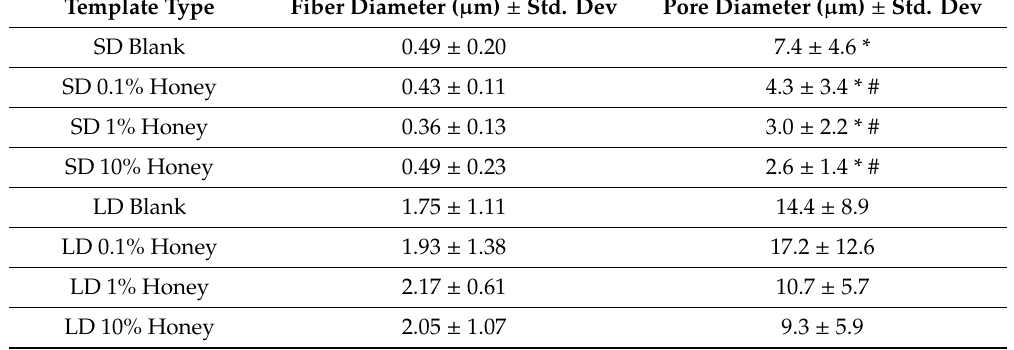
Table 3. Fiber diameters and pore diameters of each template type (mean ± standard deviation). * indicates a significant di ff erence between the pore diameters of the LD and SD templates at each honey condition. # indicates a significant di ff erence from the non-honey blank with the corresponding fiber size (SD or LD). Three images of each template type were analyzed with a minimum of 200 fiber diameter measurements and 60 pore diameter measurements taken per image. Raw data is available in Supplementary Spreadsheet 1.